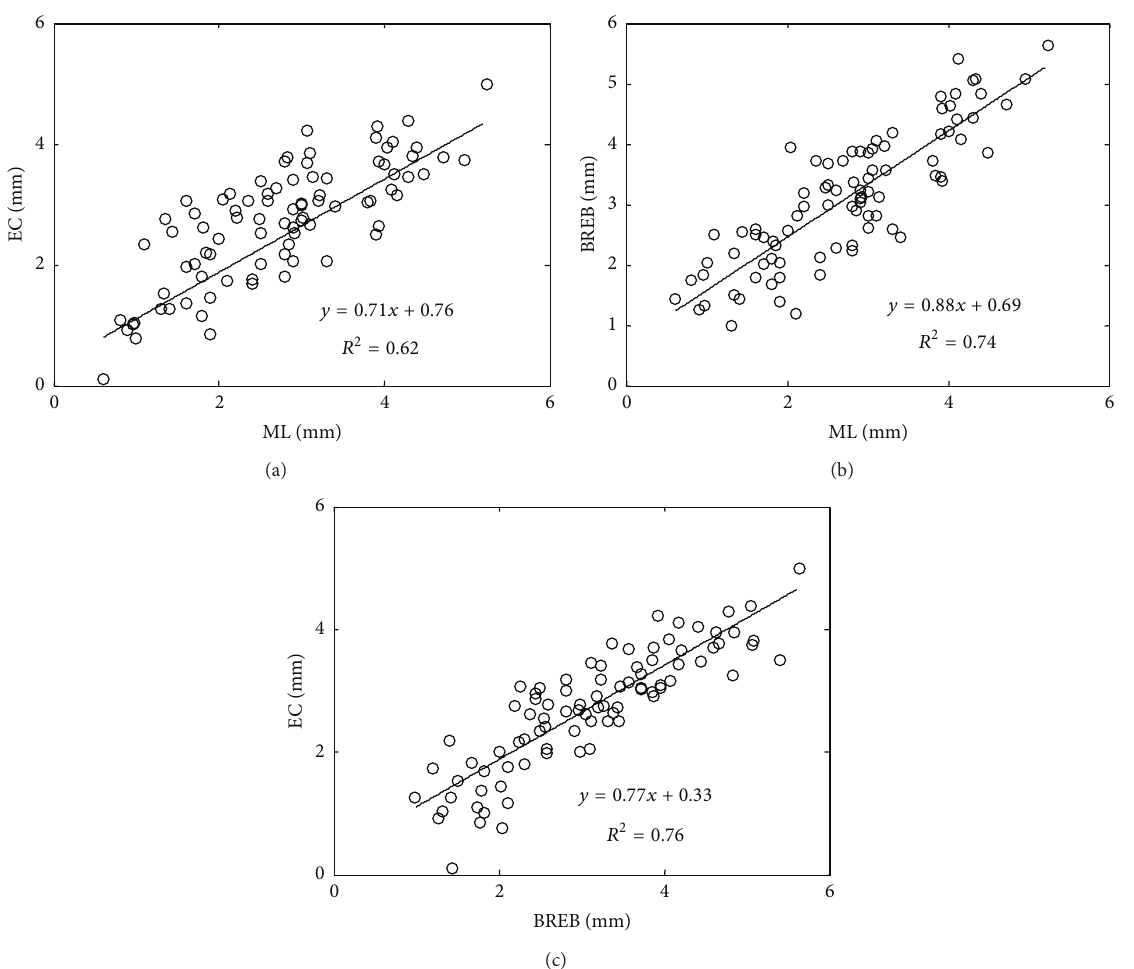
Figure 4: Relationship of evapotranspiration between EC, BREB, and